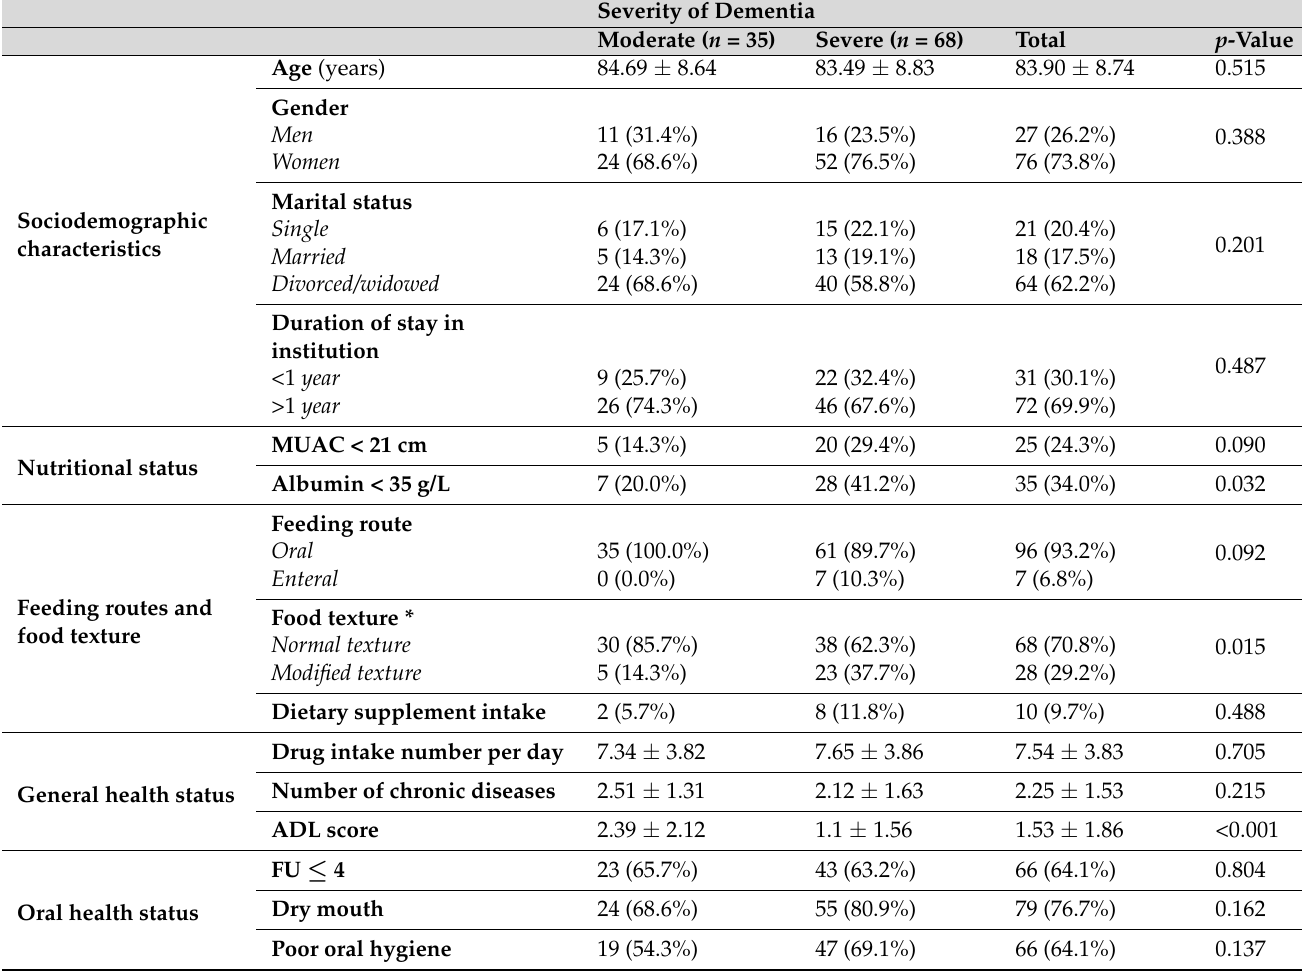
Table 1. Description of the sociodemographic characteristics, nutritional status, feeding behavior, and general and oral health status according to the severity of dementia.